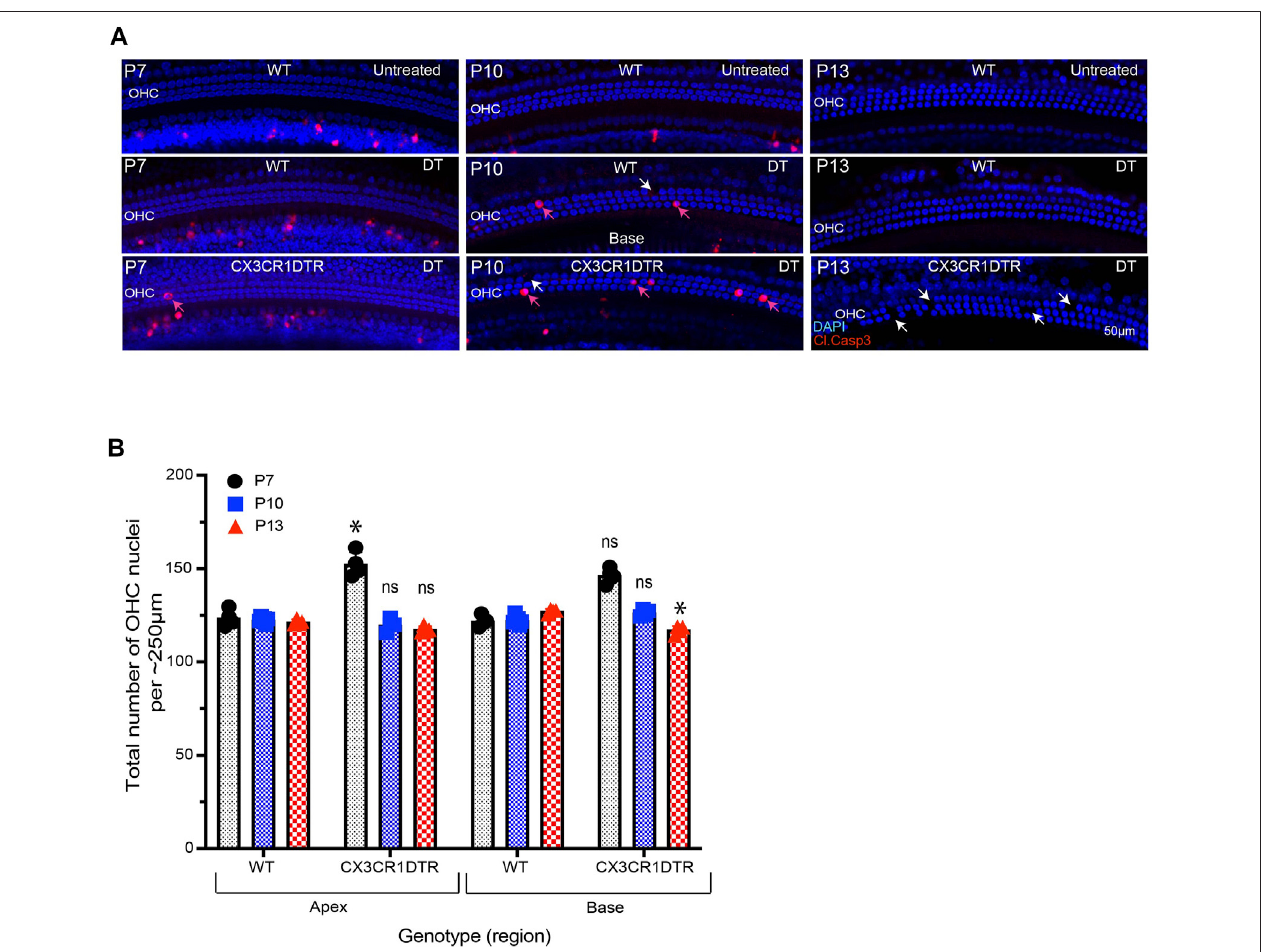
FIGURE 6 | Treatment with DT leads to loss of OHCs from the developing cochlea. (A) Apoptotic cells (red, cleaved caspase-3) in the base of the sensory epithelium of the developing cochlea. Treatment with DT caused the death of a small number of OHCs, which was evident at P7-13. (B) Total number of OHCs in the cochlea of CX3CR-DTR and control mice. Images in A were taken using a × 20 objective lens. Abbreviations: OHC: Outer hair cell, DT: Diphtheria toxin. *p: p < 0.05, relative to WT), ns: not signi fi cant. (N (cid:2) 3 – 6).